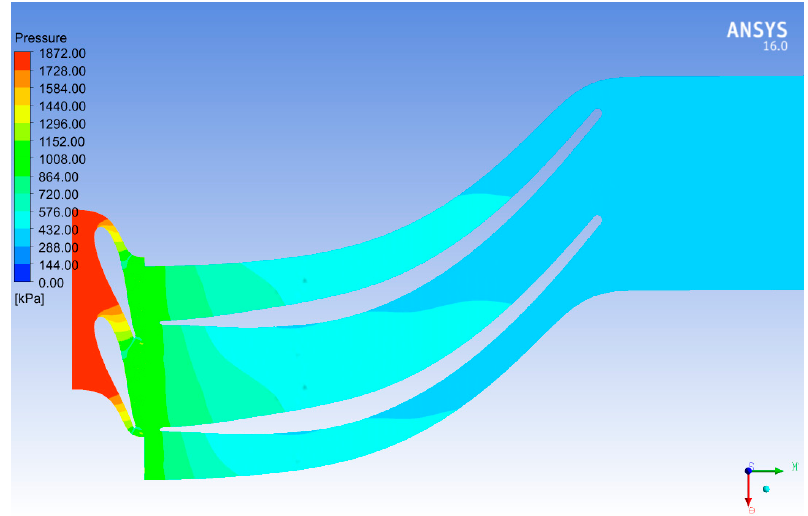
Figure 15. Two-dimansional static pressure contours through the stator and rotor blades at 50% span.